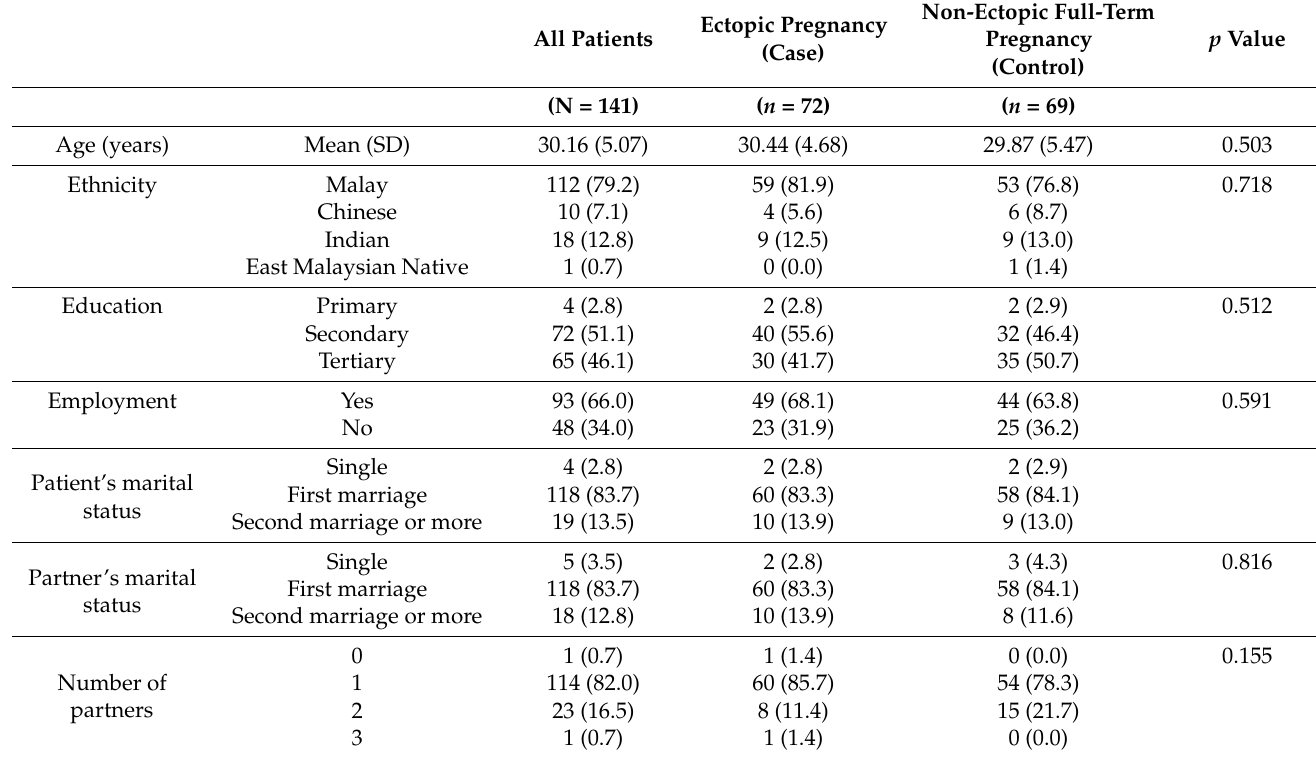
Table 1. Demographic characteristics of the study patients (N = 141).